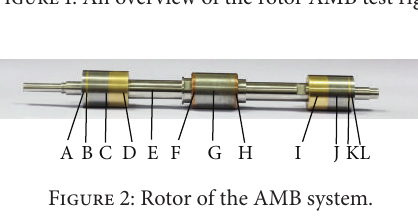
Figure 1: An overview of the rotor AMB test rig.